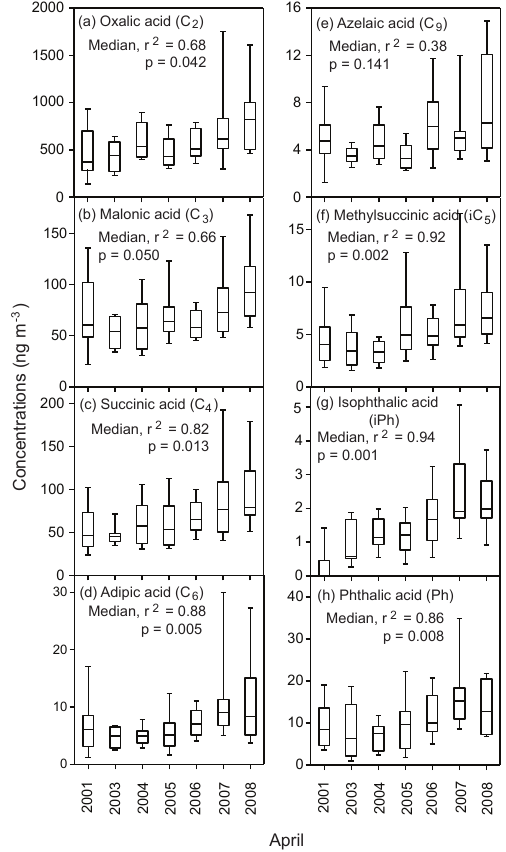
Figure 7. Correlations of levoglucosan (a biomass burning tracer) with saturated (a – e) and unsaturated (f – h) diacids in aerosol sam- ples collected from April 2003 to April 2004: (a) oxalic (C 2 ) , (b) azelaic (C 9 ) , (c) methylsuccinic (iC 5 ) , (d) ketopimelic (kC 7 ) , (e) ketomalonic (kC 3 ) , (f) maleic (M), (g) phthalic (Ph) and (h) terephthalic (tPh) acids. Note that data have been grouped ac- cording to the season.